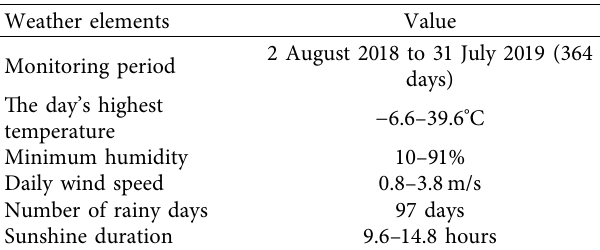
Table 9: Weather conditions during the monitoring